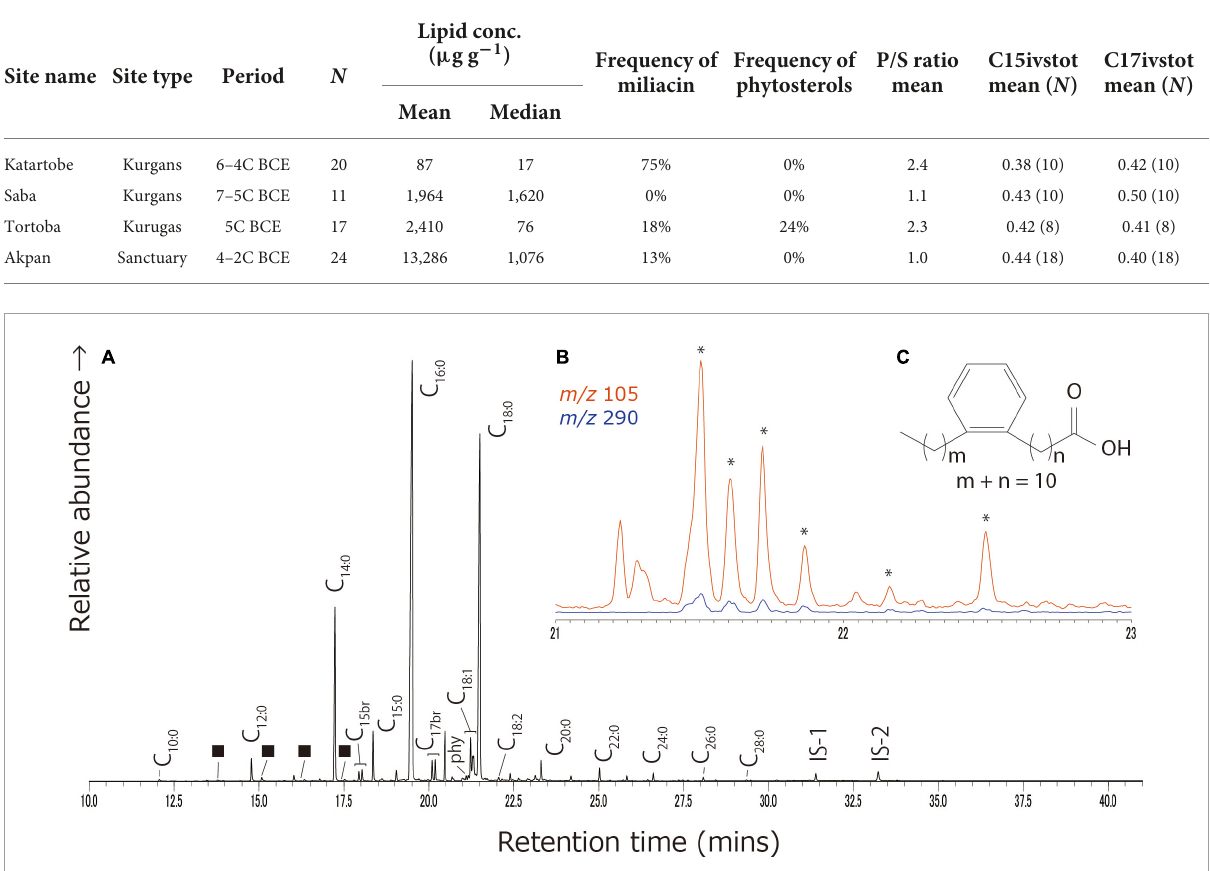
TABLE 2 Summary of the results of molecular analysis per site.